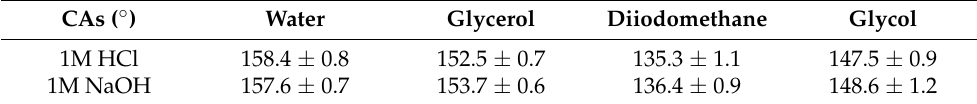
Table 4. CA of FEP-S for different liquids after immersion in HCl and NaOH solution for 1 h.